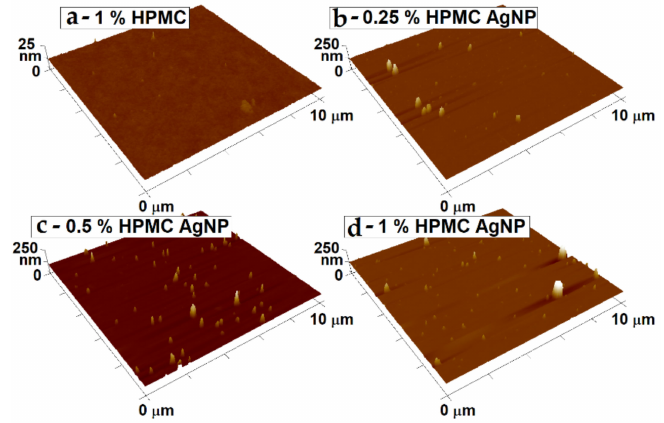
Figure 11. Surface morphology of the blank HPMC and HPMC with AgNP thin films measured by atomic force microscopy (AFM). Notice the di ff erent z axis scale in the case of the blank HPMC sample. The thin films were prepared from: ( a ) 1% solution of pure HPMC; samples of AgNPs prepared in ( b ) 0.25%; ( c ) 0.5% and ( d ) 1% HPMC